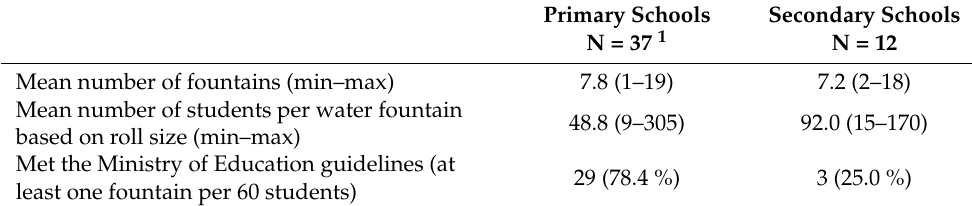
Table 3. Number of water fountains in Hawke’s Bay schools.